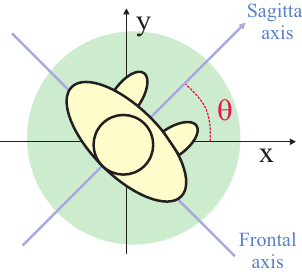
Figure 8. Basis of Asymmetric Gaussian Calculus.